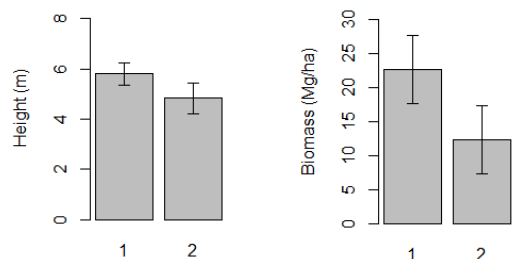
Figure 1. Comparison between structural characteristics of the two forest types from field survey, 1: Conserved forest; 2: Degraded forest